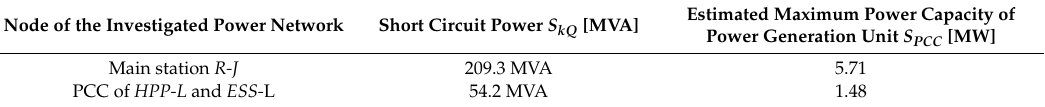
Table 4. Short circuit power in the selected node of the investigated power network and the estimated maximum power capacity of the power generation unit permissible in terms of rapid voltage change